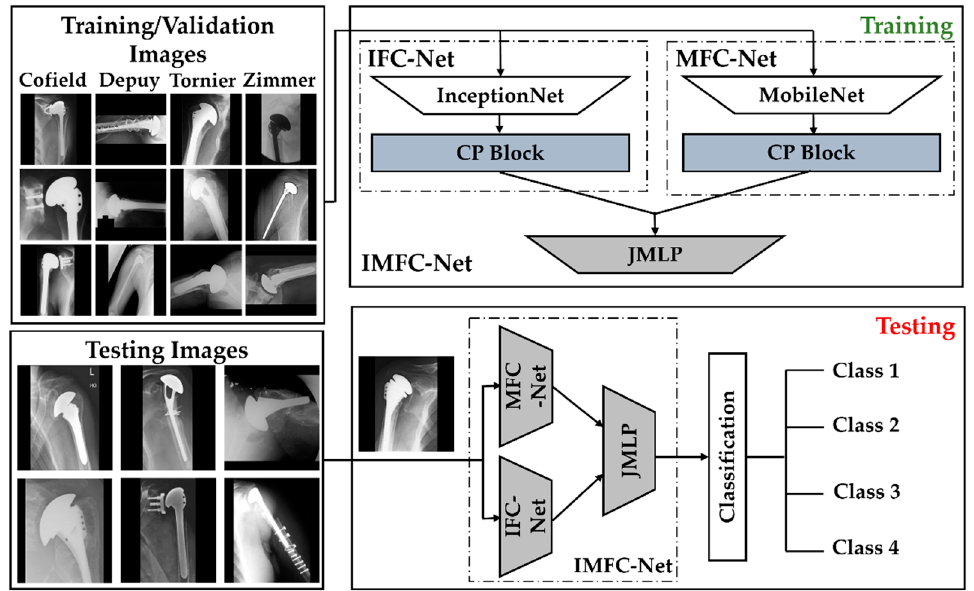
Figure 2. Flow diagram of the proposed inception mobile fully-connected convolutional network (IMFC-Net), which is an ensemble of inception fully-connected convolutional network (IFC-Net), mobile fully-connected convolutional network (MFC-Net), and a joint multilayer perceptron (JMLP) network.